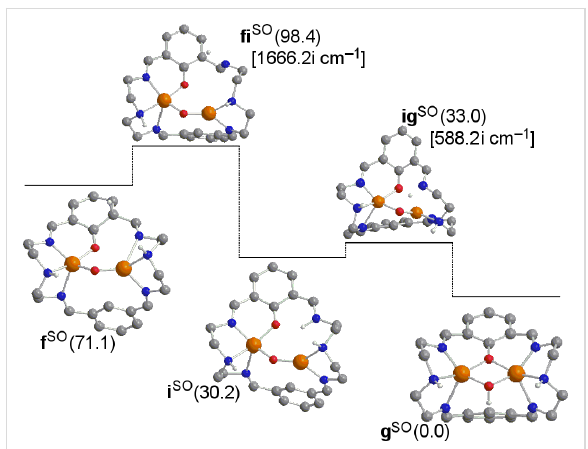
Figure 3: Computed structures for a potential alternative pathway f → g of the σ * mechanism (some H atoms omitted for clarity). Gibbs ener- gies relative to product g (in kcal·mol − 1 ) in solution are given in paren- theses. Calculated imaginary frequencies for transition structures are given in brackets. Superindex SO (open-shell singlet) refers to the multiplicity of the ground state.